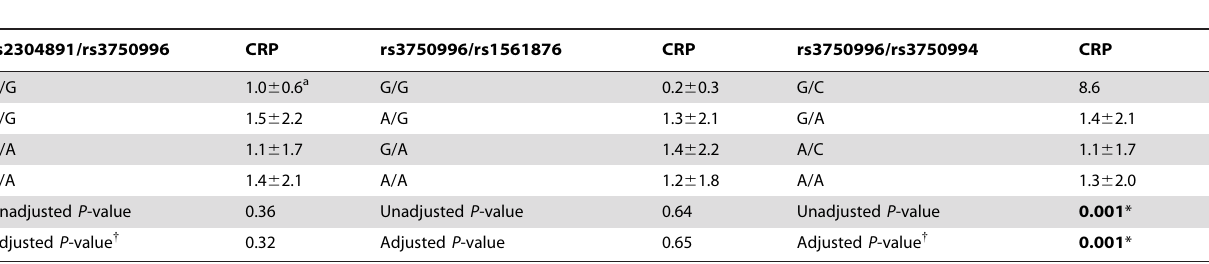
Table 5. Difference in the value of CRP among HLA-B27 positive AS patients stratified by different STIM1